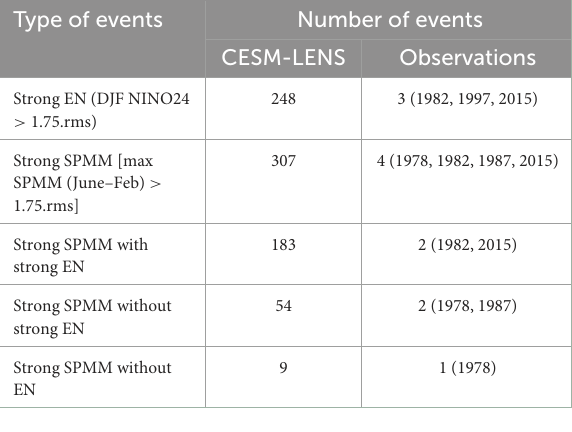
TABLE 2 Number of event types in observations and the CESM-LENS.